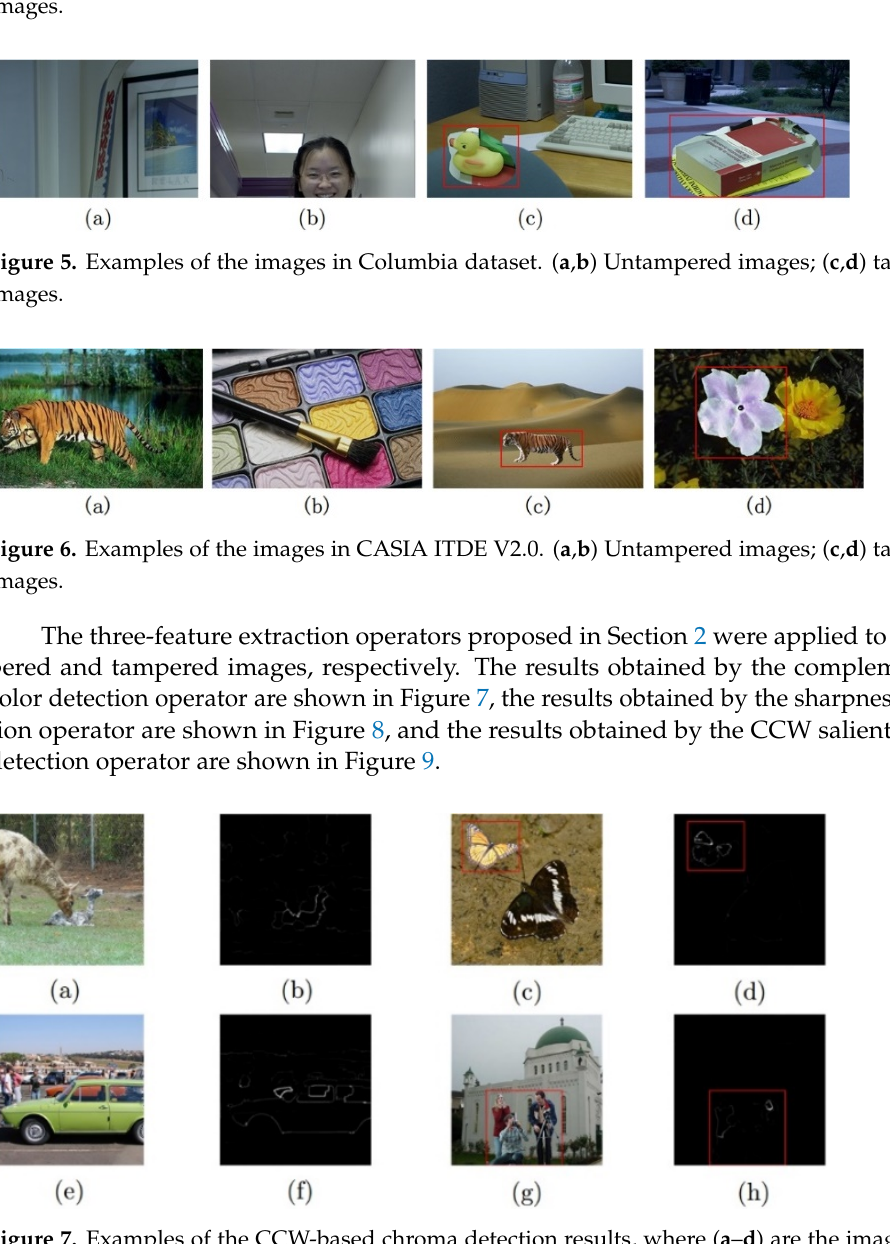
Figure 8. Examples of the sharpness detection results, where ( a – d ) are the images with correct clas- sification, and ( e – h ) are the images with failed classification. ( a , e ) Untampered images; ( b , f ) the sharpness detection results of the untampered images; ( c , g ) tampered images; ( d , h ) the sharpness detection results of the tampered images.